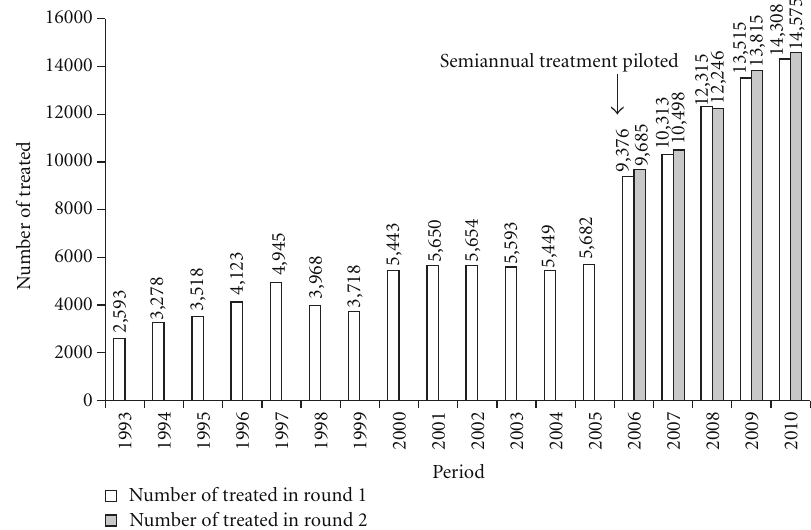
Figure 2: History of mass treatment with ivermectin from 1993 to 2010 in Wadelai onchocerciasis focus,